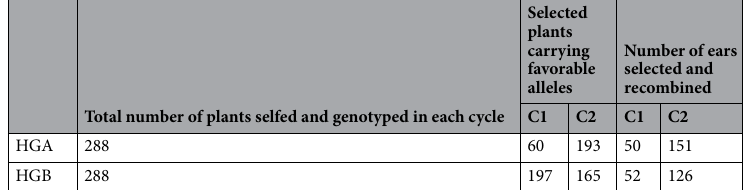
Table 1. Number of plants (with favorable allels) and ears selected for each synthetic per cycle.